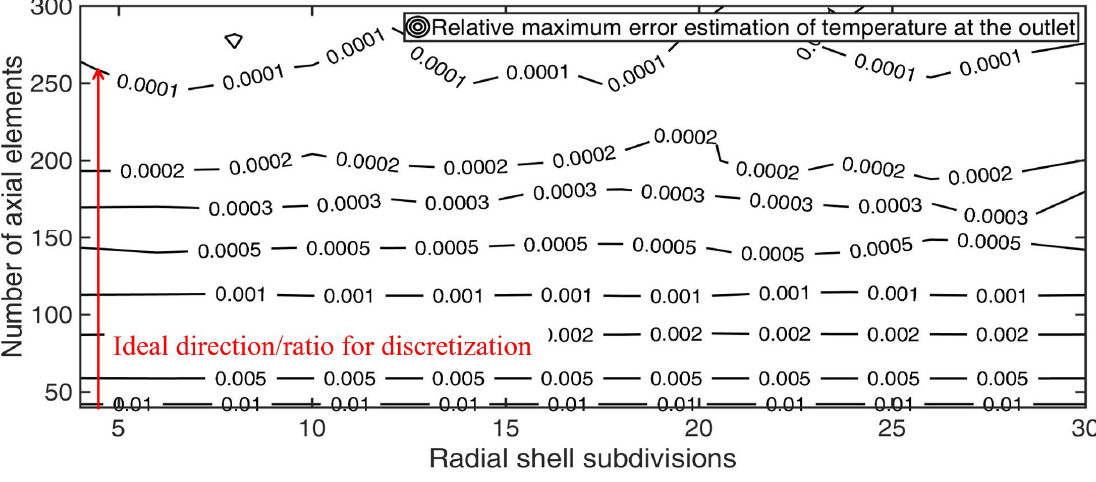
Figure 20. Estimations of maximal relative errors at the outlet of the pipe (Case 2), where the red arrow signifies the ideal direction for discretization.